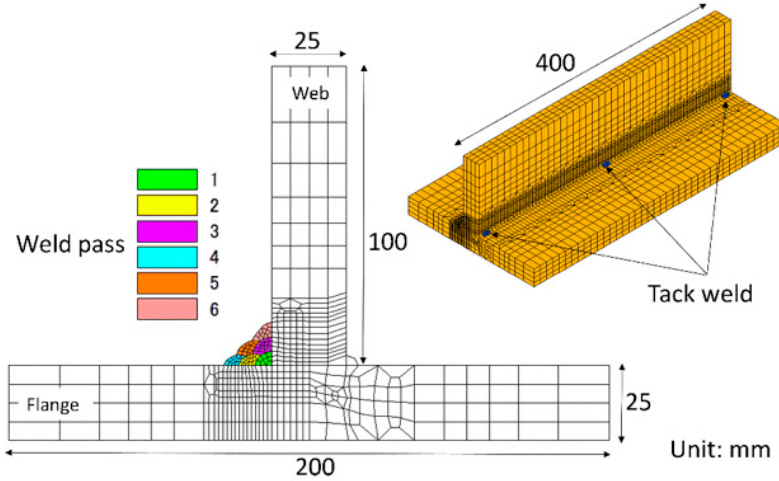
Figure 1. Schematic of a multi-pass T welded joint. Table 1. Chemical compositions (%) of the welded plate, the filler wires and their weld metals.